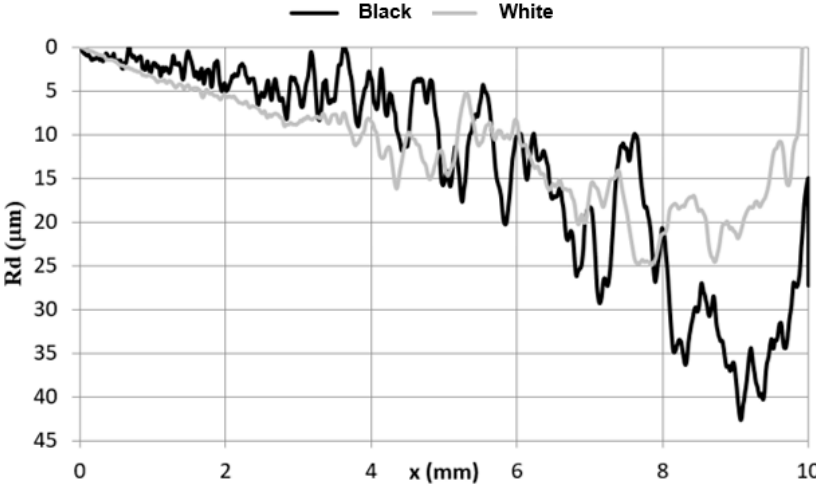
Figure 3. Average permanent crack depth (Rd) in the roof sheet